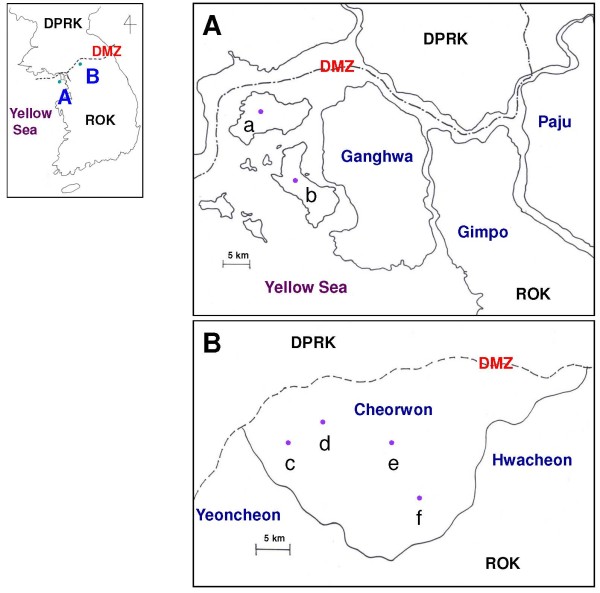
Study areas. A, Ganghwa county; B, Cheorwon county; a, Gyodongmyeon; b, Samsanmyeon; c, Cheorwoneup; d, Dongsongeup; e, Gimhwaeup; f, Seomyeon.